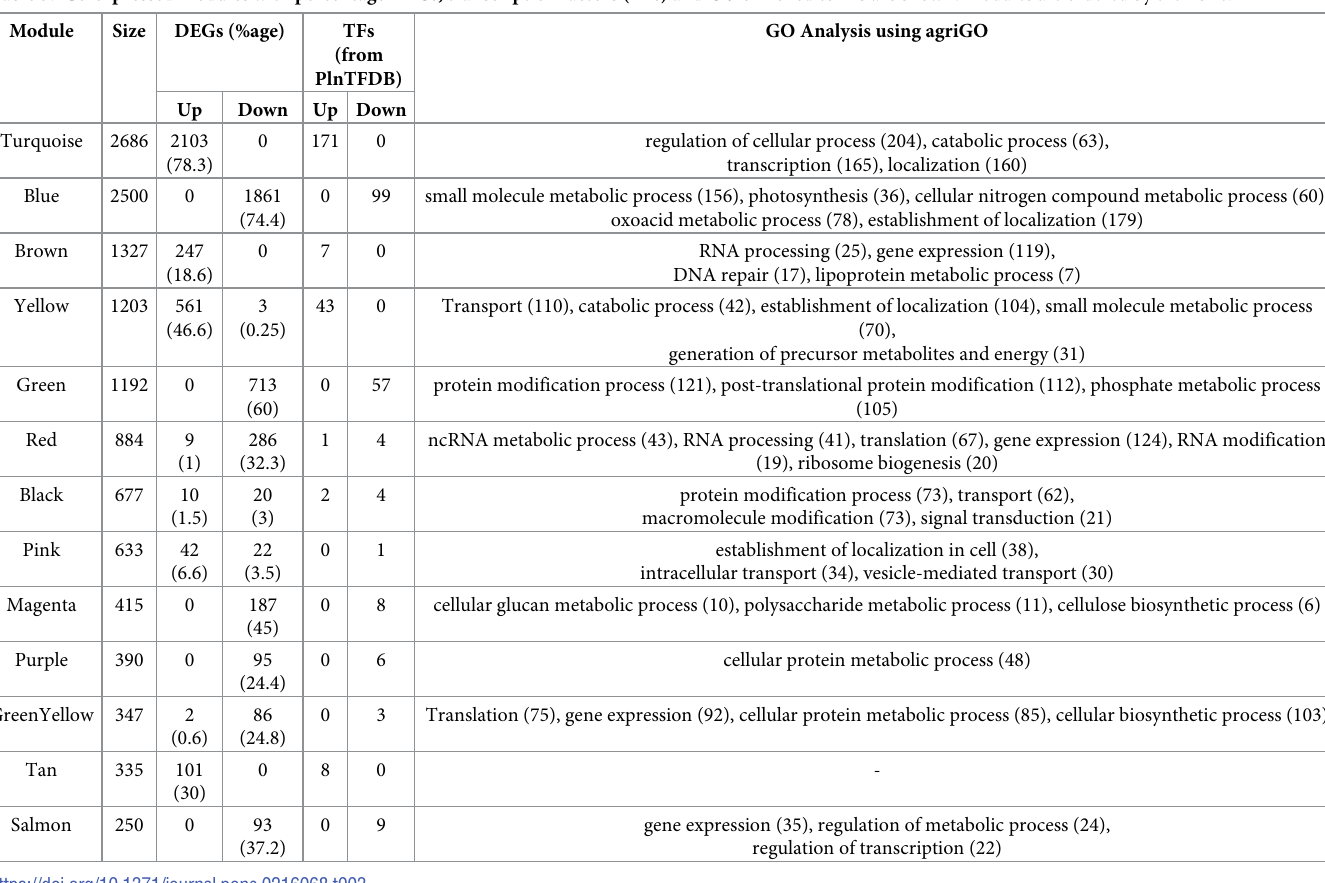
Table 3. Co-expressed modules with percentage DEGs, transcription factors (TFs) and GO enriched terms are shown. Modules are ordered by their size.